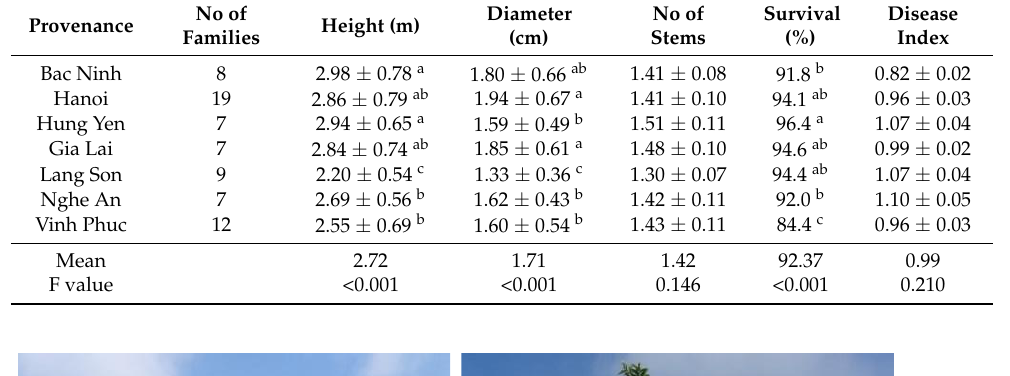
Table 1. Average height, diameter, number of stems, survival, and disease index of Dalbergia tonkinen- sis provenances at 3 years in Tan Son. Different lowercase letters in a column indicate a significant difference according to DMRT at p < 0.05.